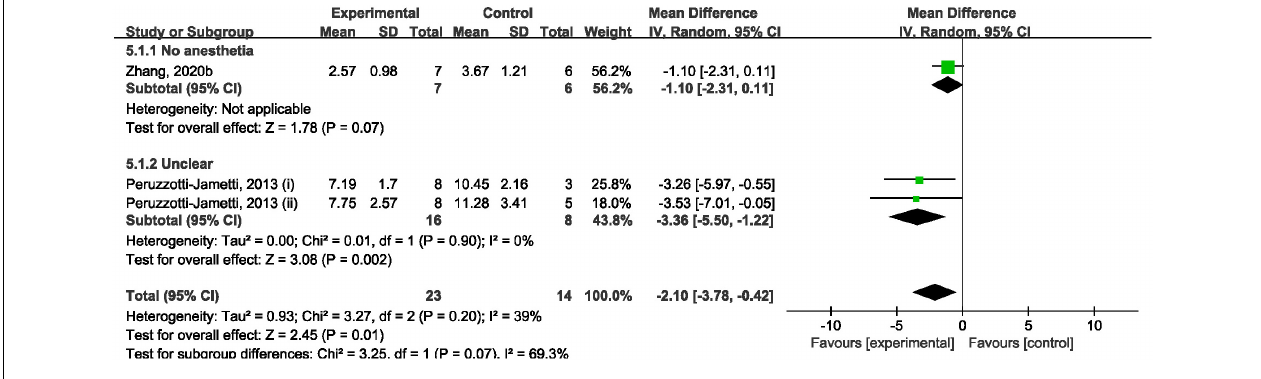
provide better evidence for clinical treatment and obtain a better